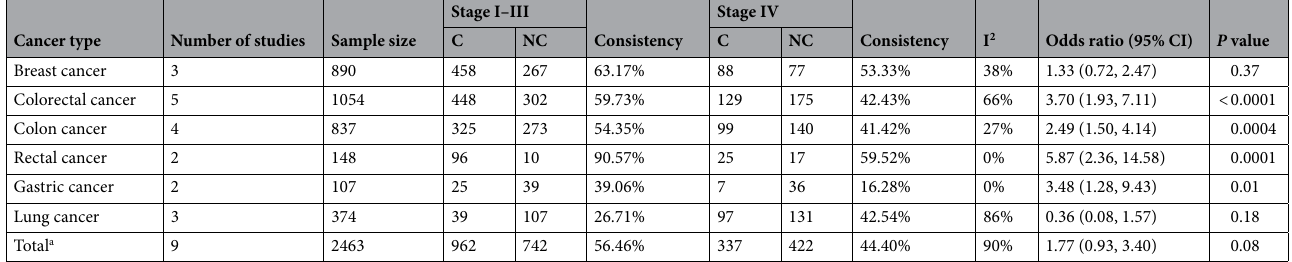
Table 3. Meta-analysis results of consistency between WFO (only ‘Recommended’) and MDT for patients with various cancers in stages I–III and IV. C Concordance cases, NC Nonconcordant cases. a The number of rectal cancer and colon cancer, which overlaps with colorectal cancer, has been excluded from the total. In addition, the total includes the number of ovarian cancer and cervical